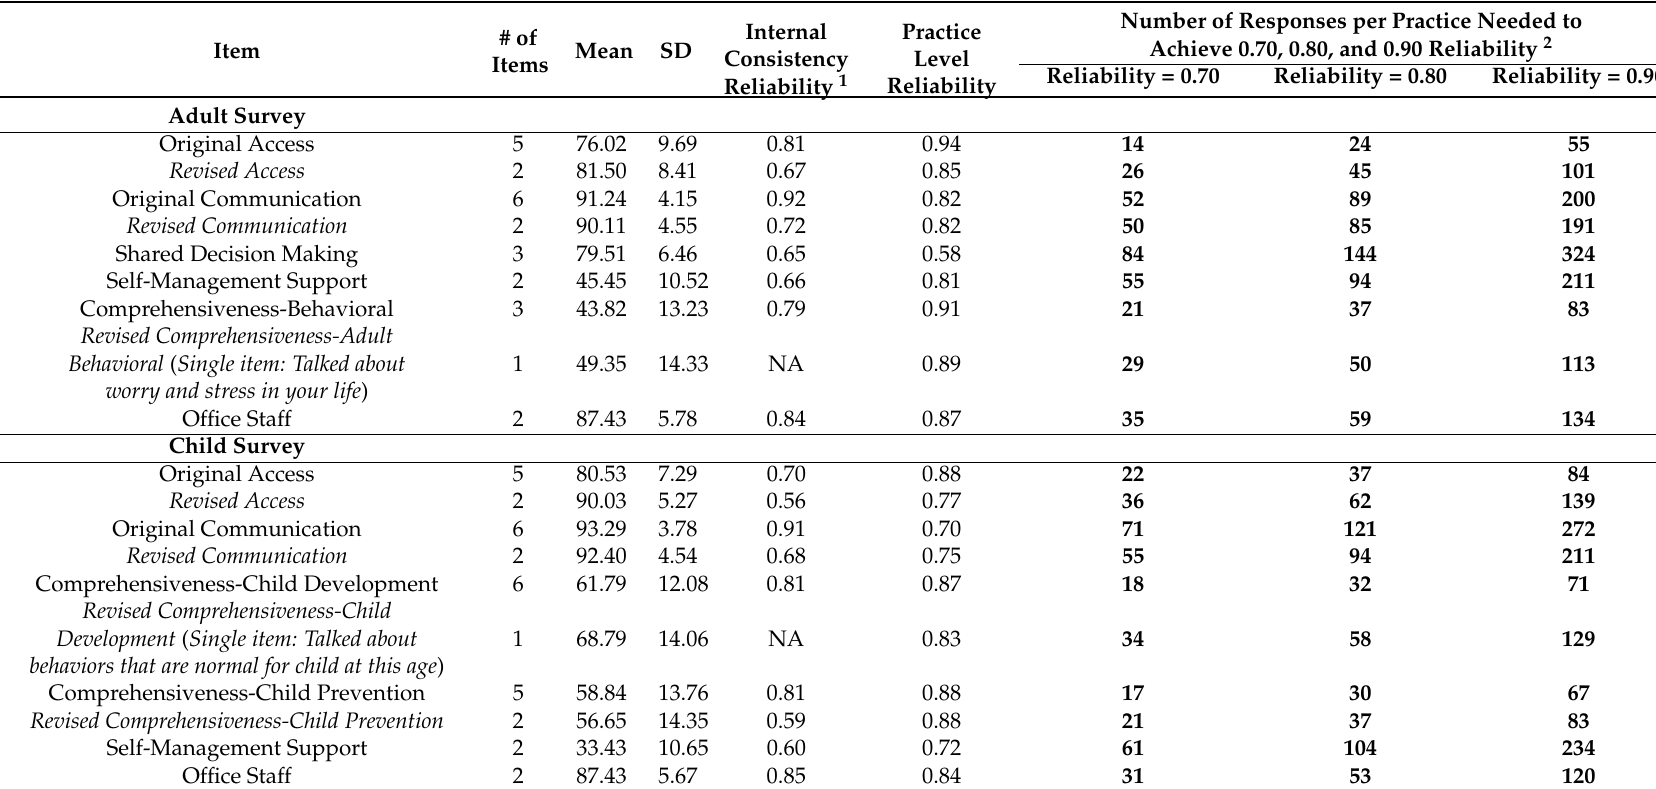
Table 4. Comparison of original composites and revised composites: Adult ( n = 268 practices) and child ( n = 58 practices) CAHPS PCMH Survey, 2013. ( Items in italics recommended for revised survey